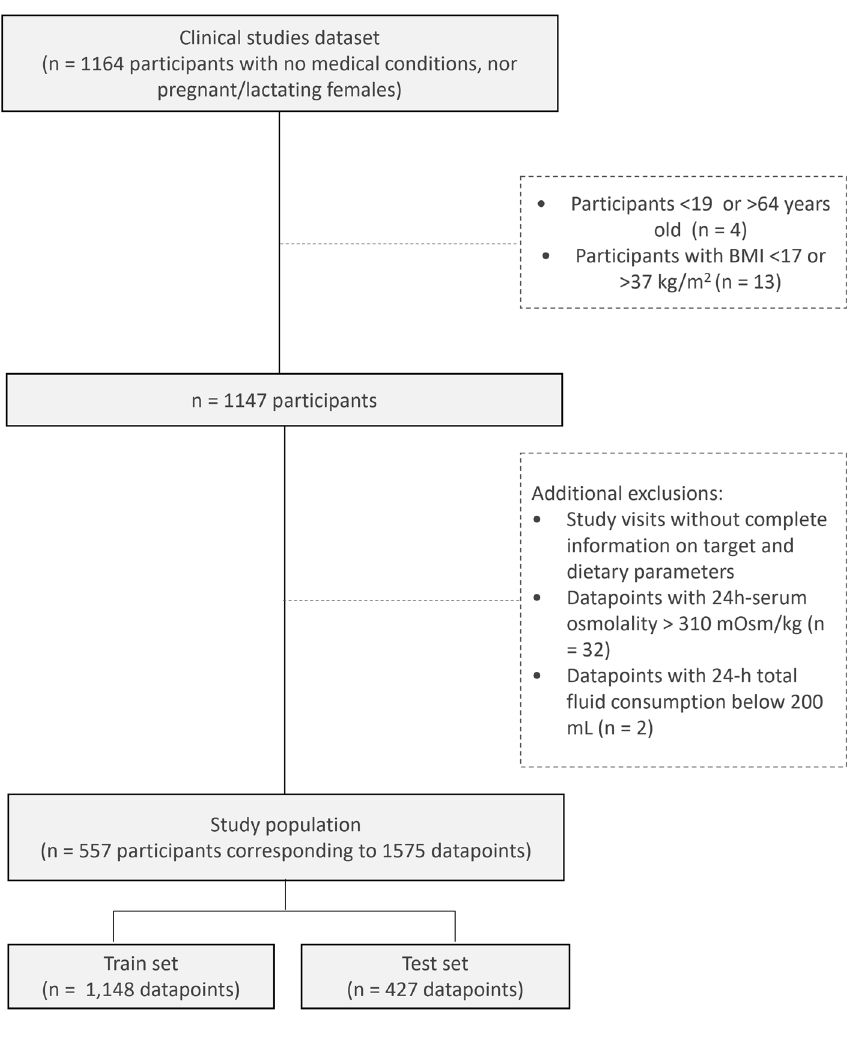
Figure 1. Participant